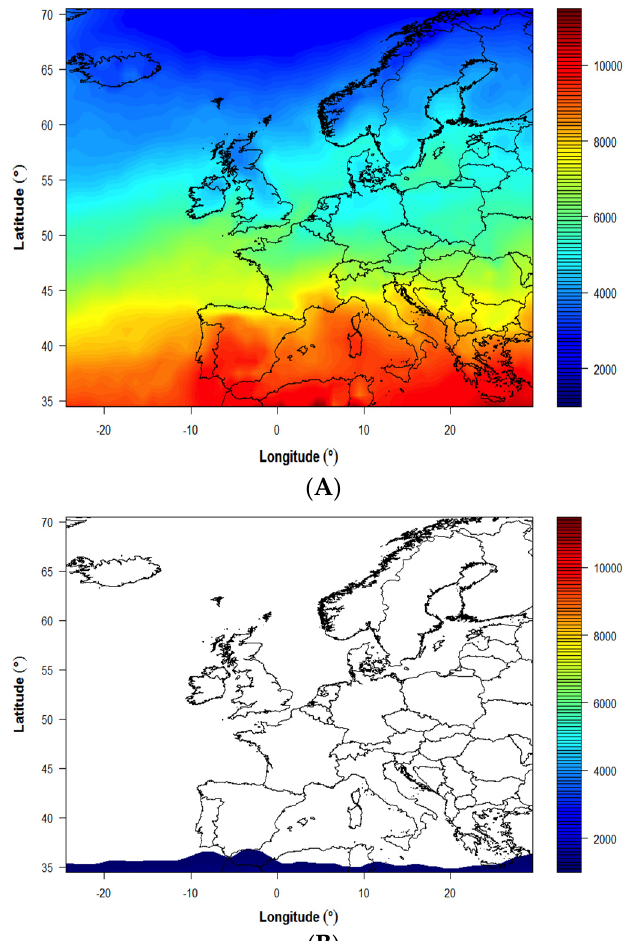
Figure 3. Mean monthly modeled UVB doses effective for pre ‐ vitamin D 3 synthesis (Jm − 2 ) across Europe for June ( A ) and December ( B ), based on average of data from years 2003–2012. Scale begins 1000 Jm − 2 .